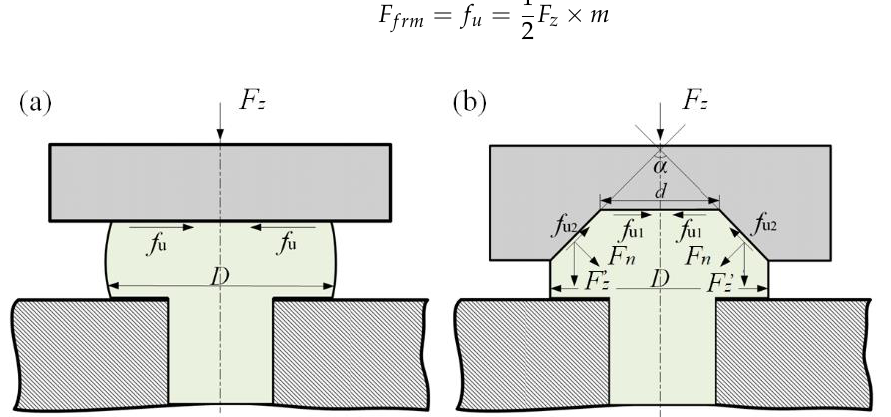
Figure 6. Comparison analysis of radial force. ( a ) Flat rivet mold. ( b ) Special rivet mold.